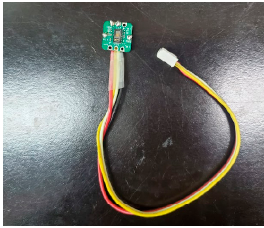
Figure 7. The heart-rate and pulse-oximetry sensor.